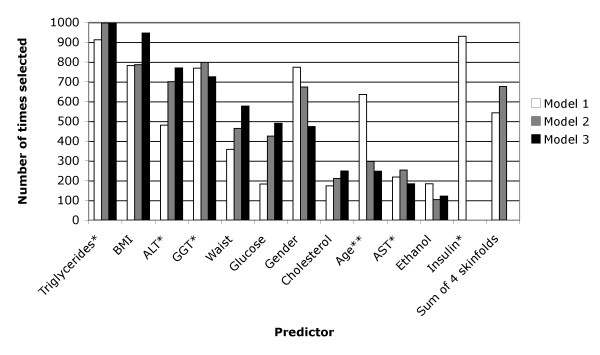
Selection of candidate predictors at bootstrapped stepwise logistic regression. Bars indicate the number of times out of 1000 that the variables were selected for inclusion in 3 models. Model 1 is the starting model, Model 2 removes insulin and Model 3 removes skinfolds. Data are sorted using Model 3. Abbreviations: * = transformed using natural logarithm; ** = transformed using Box-Tidwell transformation (see text for details); other abbreviations as in Table 1.